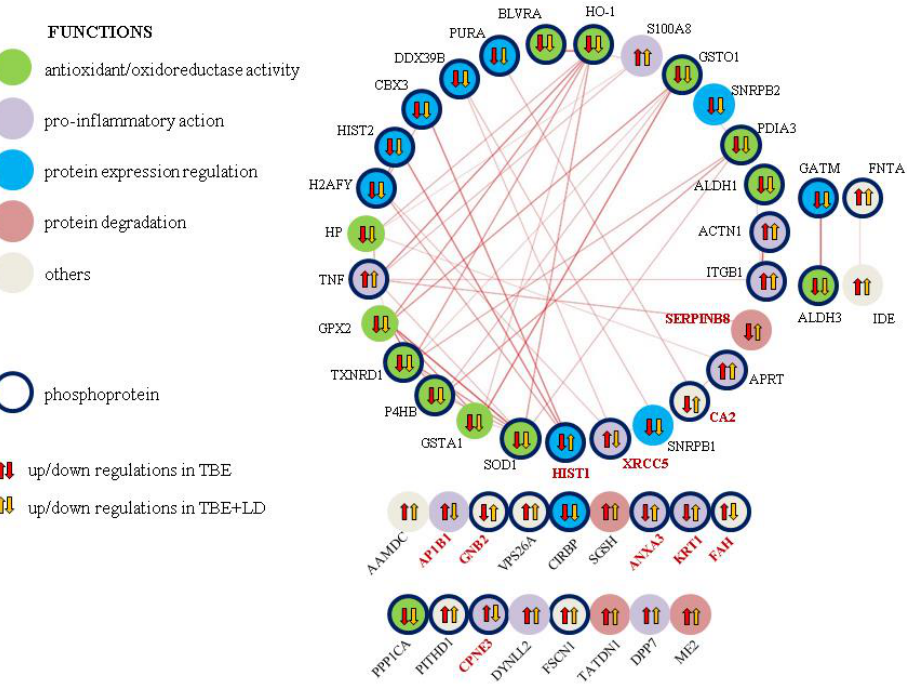
Figure 4. The protein network and biological functions of top proteins significantly changed in the plasma of patients with tick-borne encephalitis (TBE) and patients with TBE and co-infection (TBE+LD) compared to the healthy donors constituting the control group (CTR). The red marks the proteins whose expression changed differently in TBE and TBE+LD.